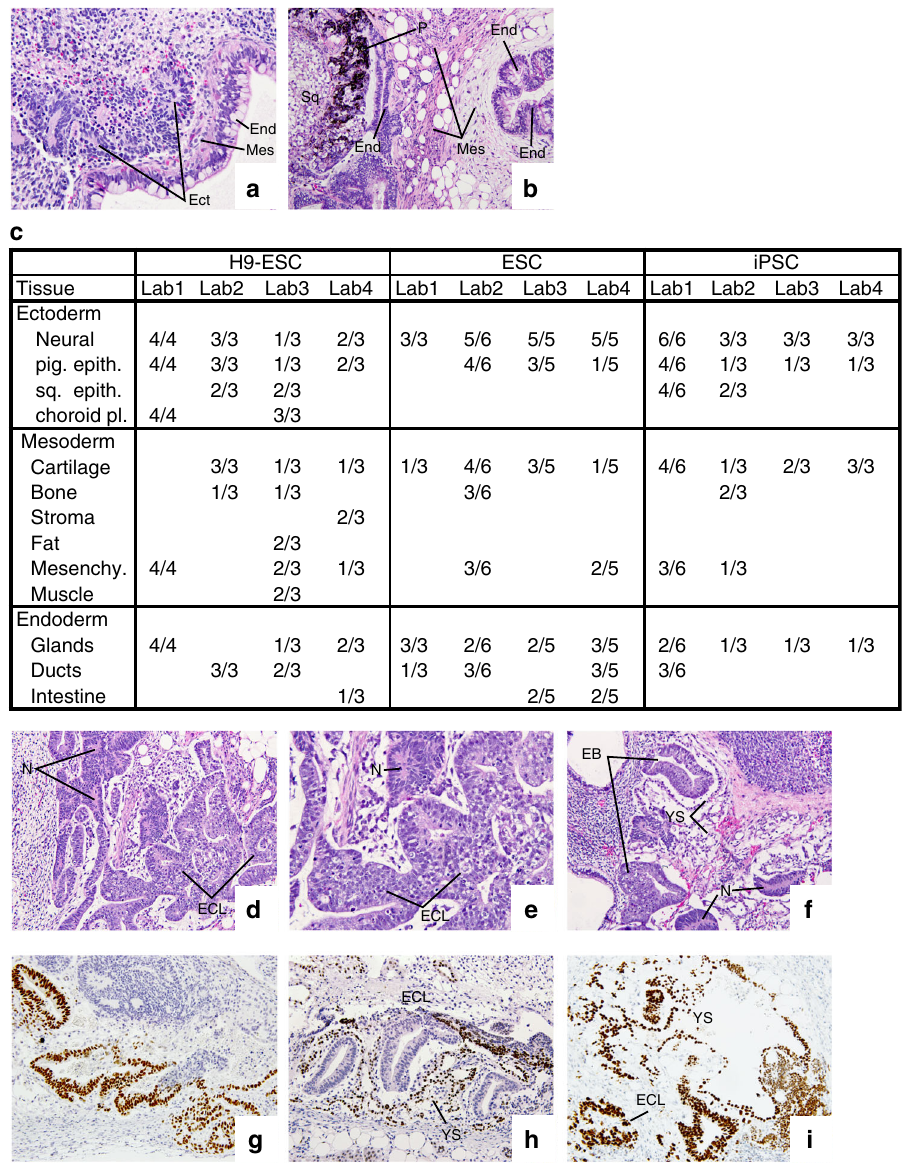
Fig. 4 Histological evaluation of three embryonic germ layers and undifferentiated EC-Like and yolk sac elements in xenograft tumors. a Mucus secreting intestinal-like epithelium (End-endoderm), neural tube rosettes (Ect-ectoderm), and intervening stroma (Mes-mesoderm) (×240). b Intestinal-like epithelium (End-endoderm), surrounded by connective tissue, smooth muscle and fat cells (Mes-mesoderm). The left outer rim of mesoderm is lined by intestinal-like epithelium (End-endoderm). To the left there is pigmented epithelium (P), corresponding to retina (Ect-ectoderm), and a nest of glycogen rich squamous epidermal cells (Sq) (×120). c A summary of tissue types recorded per individual tumor piece surveyed from each laboratory; at least two pieces of each tumor were examined. d Lower magni fi cation view of a teratoma containing undifferentiated stem cells (EC-Like, ECL), identi fi ed as embryonal carcinoma-like (ECL) cells, neural tube-like rosettes (N) and non-descript stromal cells (×120). e Higher magni fi cation of the same xenograft. Undifferentiated ECL cells (ECL) are arranged into anastomosing cords. Dark dot-like cells are undergoing apoptosis. Compare the loosely structured chromatin of the ECL cells with the dark nuclei containing condensed chromatin in the neural rosettes (N) (×240). f Two embryoid bodies (EB) forming tubes lined by ECL cells, separated by a space from the surrounding yolk sac epithelium (YS). Both embryoid bodies contain prominent apoptotic bodies. Note the loosely textured yolk sac (YS) corresponding to the connective tissue that runs between the yolk sac and the blastocyst (magma reticulare) of early human embryos (×120). g Antibody to OCT3/4 staining ECL cell nuclei. h Antibody to the zinc- fi nger protein ZBTB16 reacts with the nuclei of yolk sac cells around three cylinders of ECL cells. i Antibody to SALL4 staining ECL cell nuclei and also the yolk sac (YS) cells in their